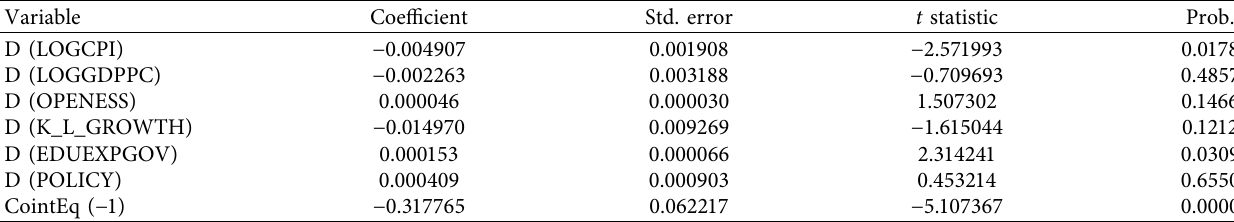
Table 5: Short-run coefficients: dependent variable is log of life expectancy at birth (years).